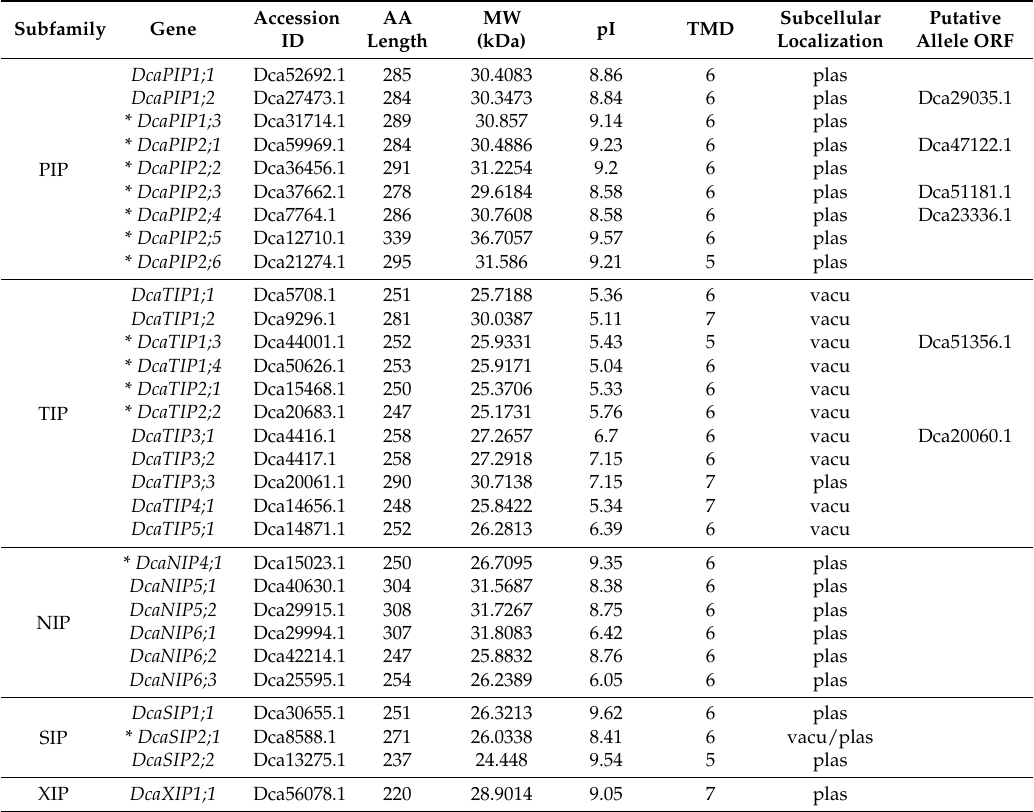
Table 1. Nomenclature and protein properties of